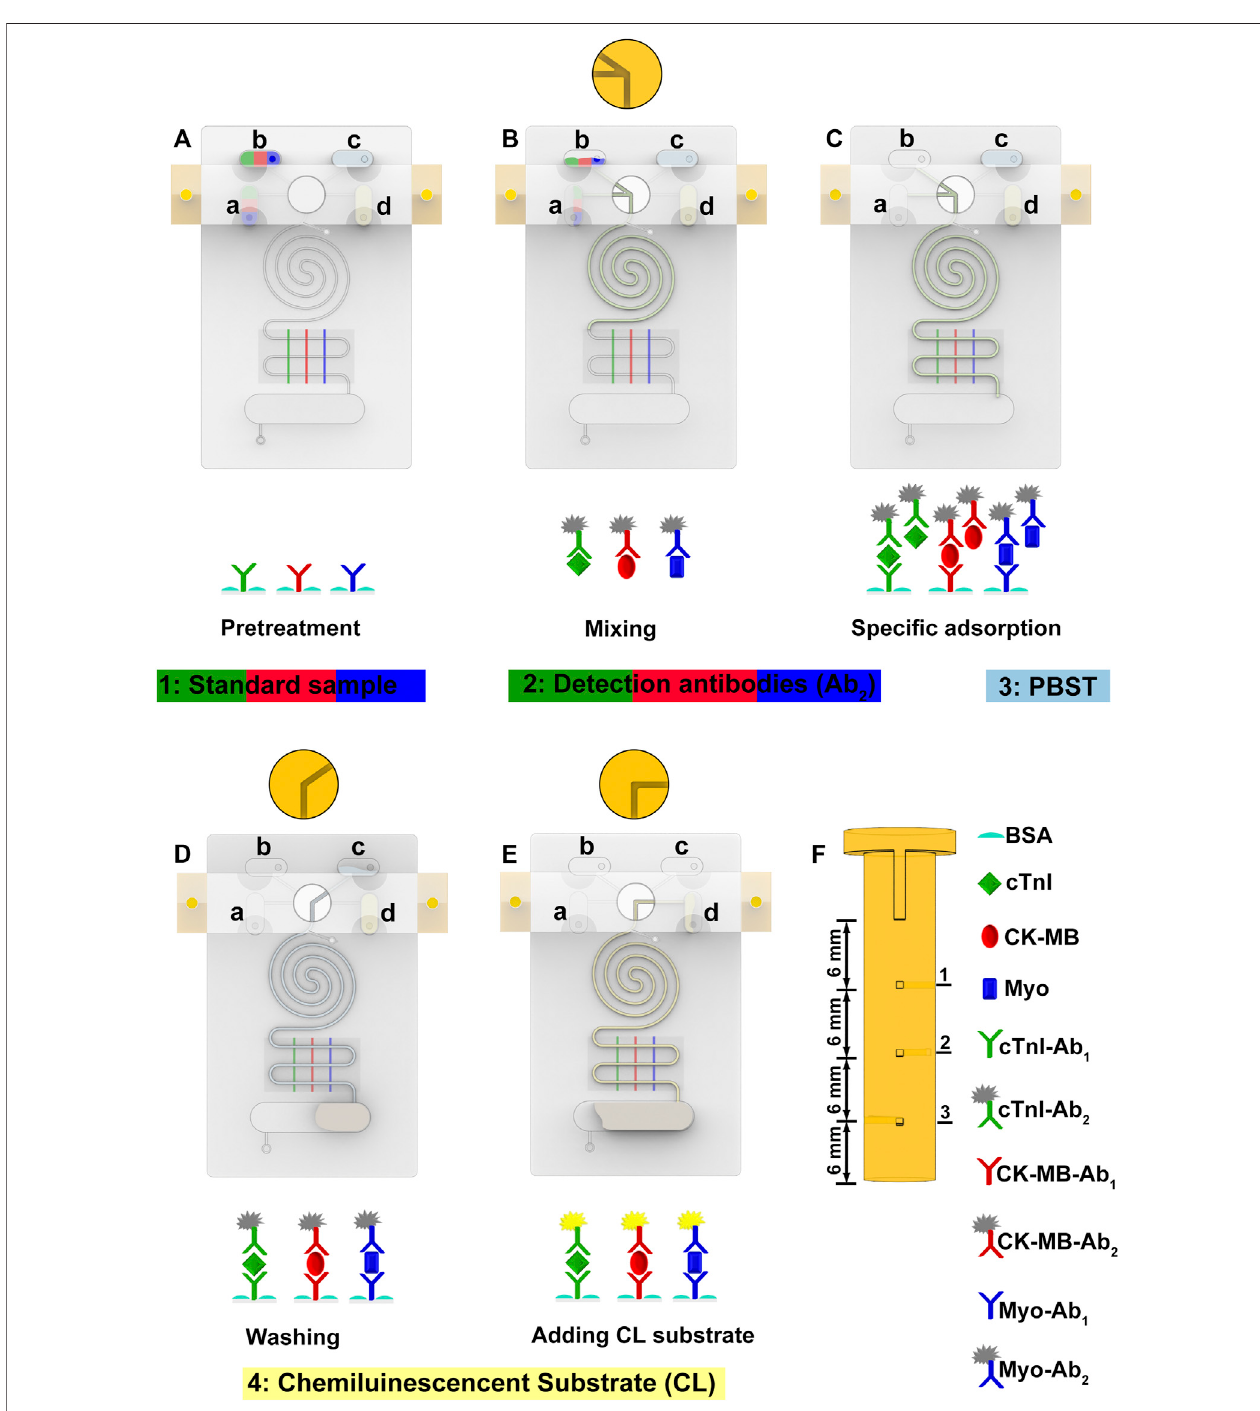
FIGURE2| ValidationoftheprecisemicrochannelandthroughholeofthePMvalve. (A) Longitudinalsection oftheS-shapedmicrochannel.Thedesignedwidthis 400 μ m, the actual width is 399.49 μ m, and the deviation is 0.13%. (B) Longitudinal section of the Archimedean spiral microchannel. The design width is 400 μ m, the actualwidthis405.10 μ m,andthedeviationis1.28%. (C) Cross-sectionoftheS-shapedmicrochannel.Thedesignedheightis400 μ m,theactualheightis400.34 μ m, and thedeviationis0.09%. (D) Cross-sectionofthePMvalve.Thedesignedwidth is400 μ m; theactualwidth is391.09,403.01,and409.04 μ m; andtheaverage deviation is 1.75%.